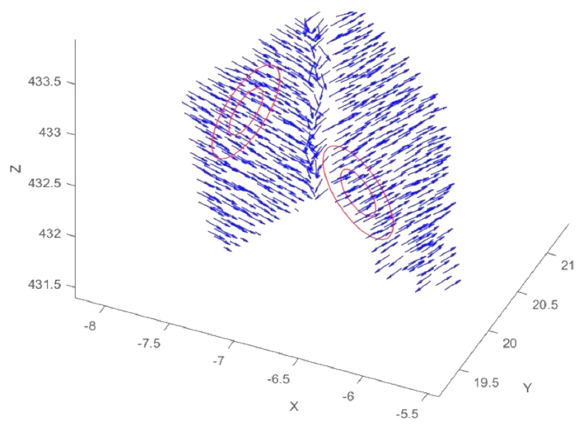
Figure 3. Local normal vectors around the points far from the edge and near the edge.